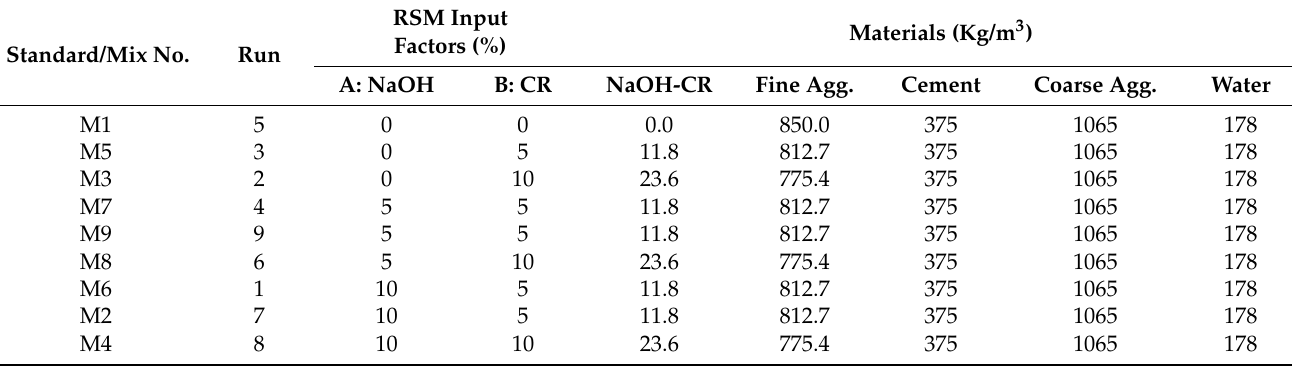
Table 2. Response surface methodology (RSM) developed mixes and materials